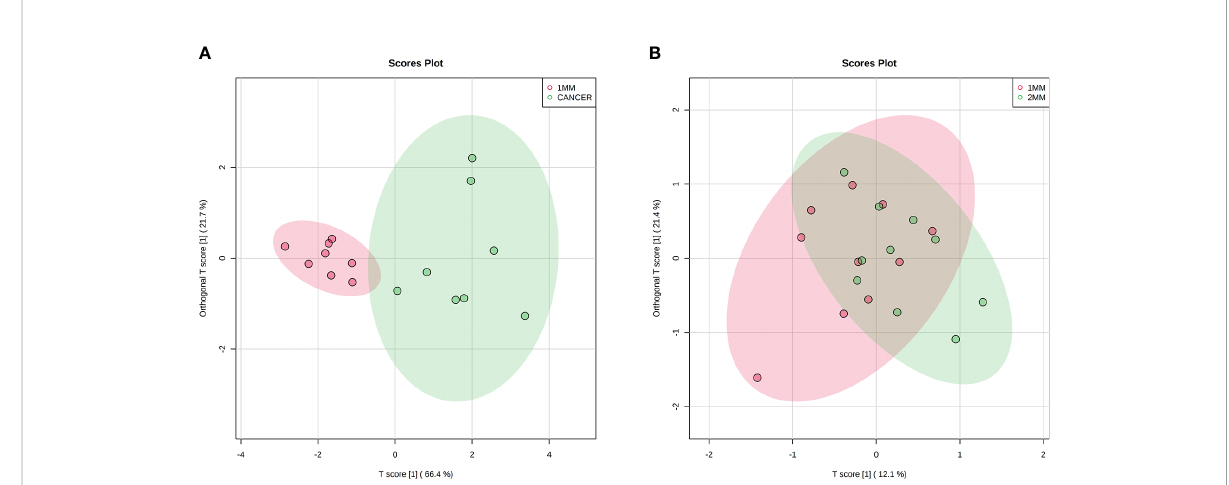
FIGURE 6 Orthogonal partial least squares discriminant analysis (OPLS-DA) score plots of 6 potential biomarkers in tissue located at 1 mm surgical margin and cancerous tissue (A) , showing a clear separation. Orthogonal partial least squares discriminant analysis (OPLS-DA) score plots of 6 potential